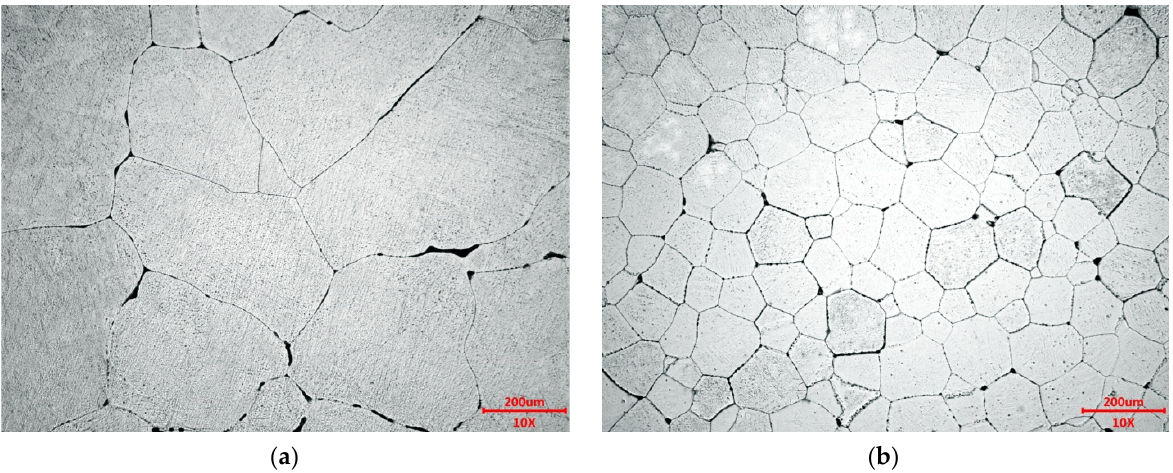
Figure 3. OM microstructure of ( a ) as-cast Mg-0.5Ca-0.5Zr alloy and ( b ) as-cast Mg-0.5Ca-1Zr alloy.